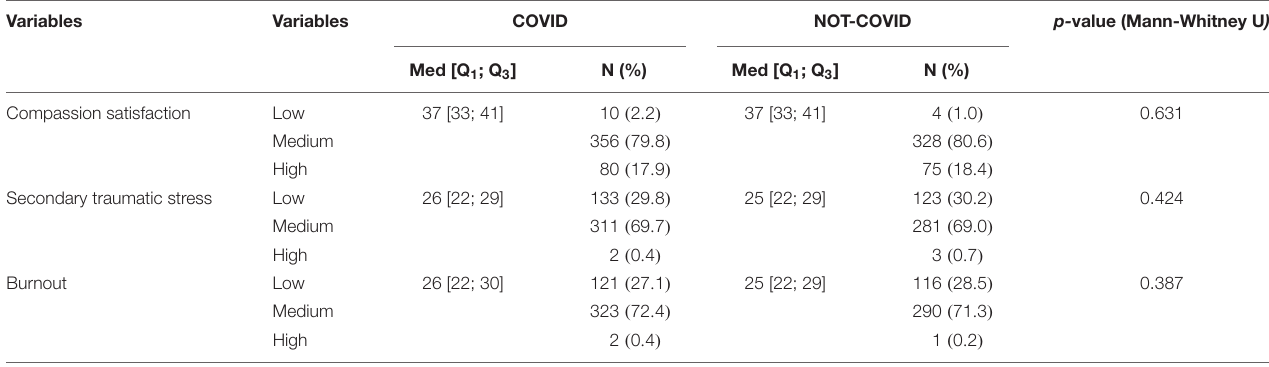
TABLE 2 | Professional quality of life—COVID or NOT_COVID. Variables